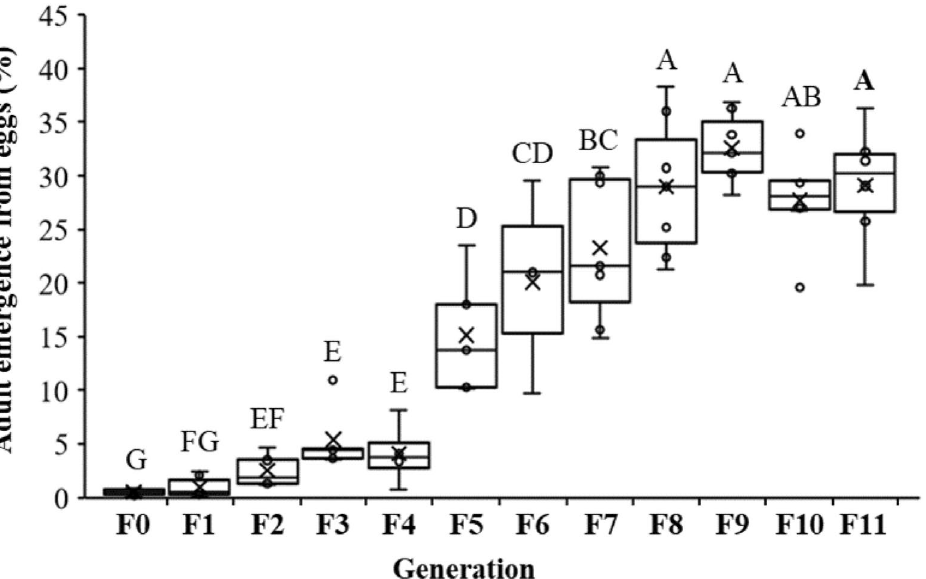
Figure 1. Percentages of adult emergence from egg hatch within 26–32 days post oviposition. Tukey’s box plots with median (black line), the 25th and 75th percentiles (bottom and top of box, respectively), and the 5th and 95th percentiles (whiskers) are shown. Boxes with different letters are significantly different ( P <